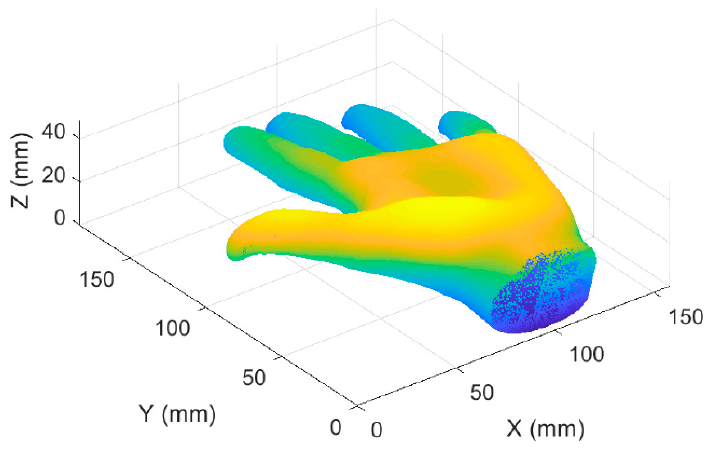
Figure 4. 3D point cloud of the human hand used for the forefinger and thumb orthosis.